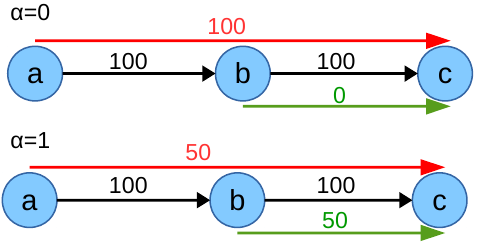
Figure 5. Efficiency ( α = 0) vs. fairness ( α = 1) example. Blue circles: nodes; black arrows: links; colored arrows: data flows; numerical values: link speeds resp. flow assignments in Mbps.